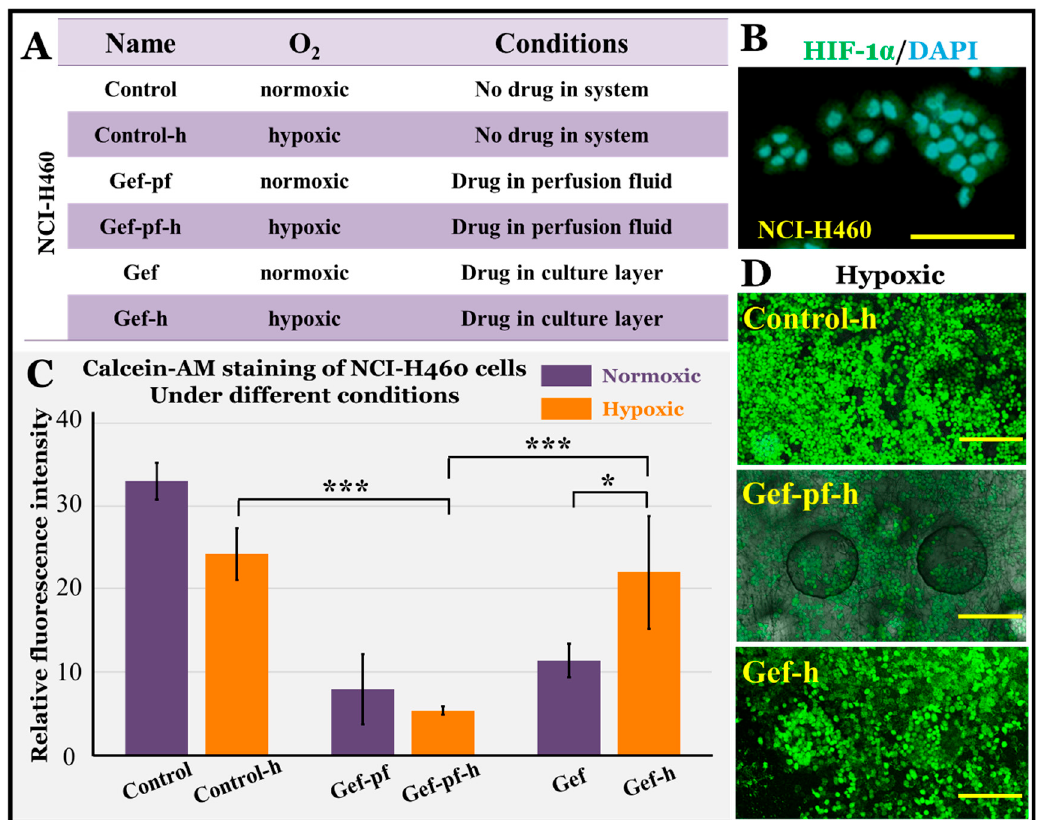
Figure 6. ( A ) Grouping and labeling of NCI-H460 cells drug evaluation under normoxic and hypoxic conditions. ( B ) HIF-1 α expression of NCI-H460 cells. HIF-1 α : green; DAPI for cell nucleus: blue. Bar = 100 µ m. ( C ) Histogram of the average relative fluorescence intensity of calcein-AM staining of NCI-H460 cells in di ff erent groups under normoxic and hypoxic condition. The standard errors were obtained from Student’s t -test. n = 4; *** p < 0.005; * p < 0.05. ( D ) Calcein-AM fluorescence image of NCI-H460 cells in di ff erent groups under hypoxic condition. Calcein-AM: green. Bar = 200 µ